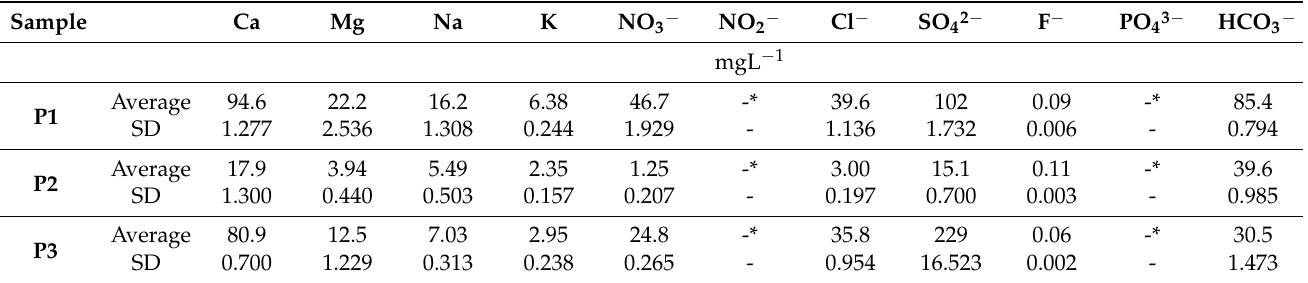
Table 4. The cations and anions concentration in the surface water samples in the year